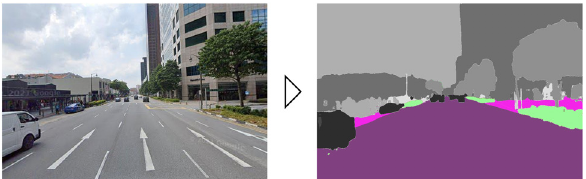
Figure 7. Example of impervious and pervious features (purple–road, pink–sidewalk, green–grass) extracted based on model trained on Cityscape dataset (Cordts et al.,